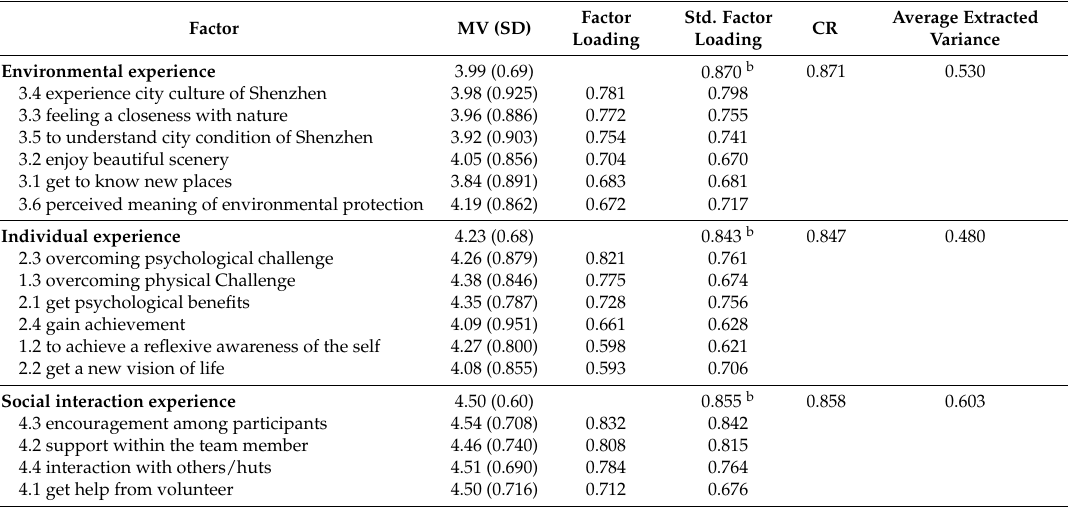
Table 5. Confirmatory factor analysis for walking event